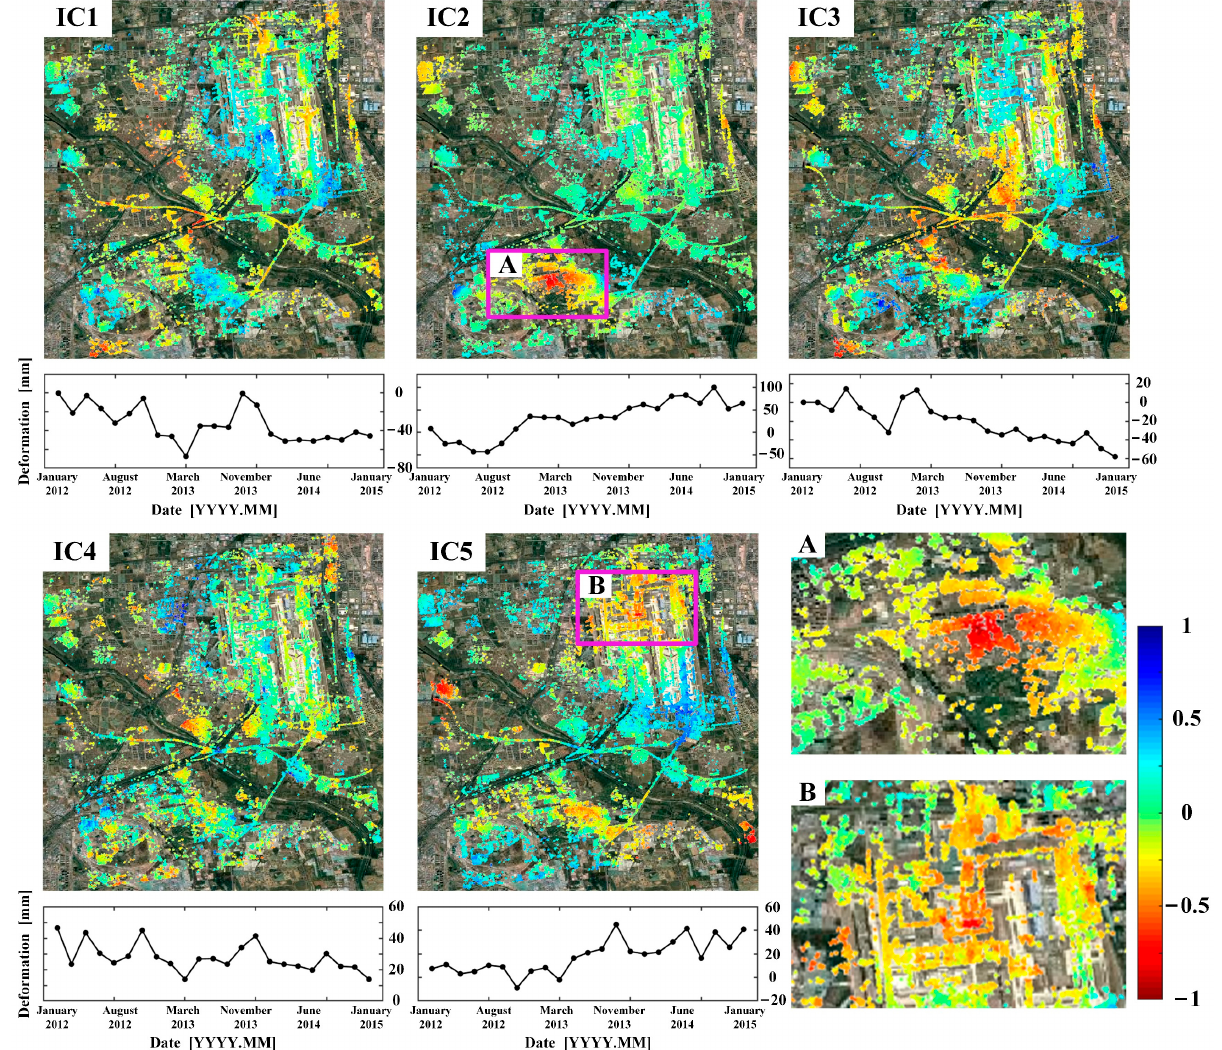
Figure 5. The spatial–temporal response of each independent component ( top : spatial response of each independent component; bottom : time series of each independent component; Areas A and B were two typical subsiding areas.).